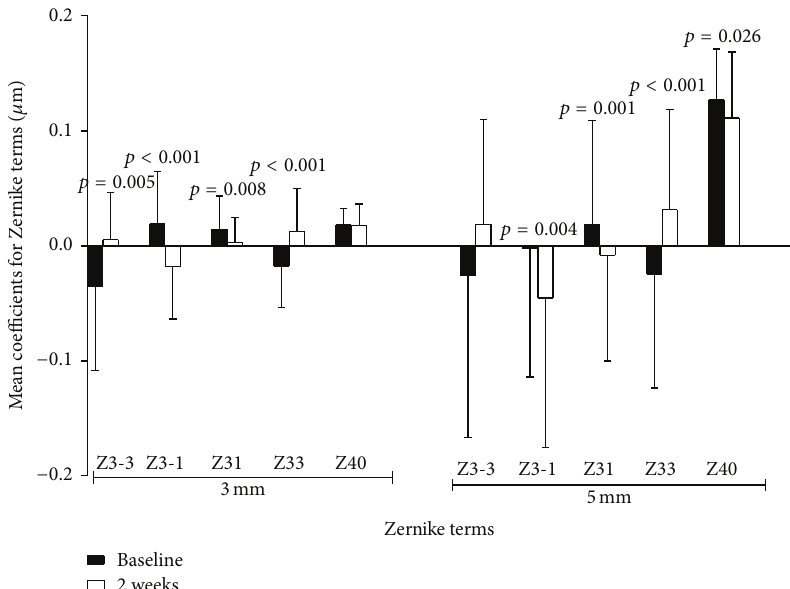
Figure 4: Zernike terms in treatment group. Vertical coma and horizontal coma decreased significantly at a 3 mm zone. Vertical coma, horizontal coma, and SA had significant mathematical decrease at 5 mm zone.